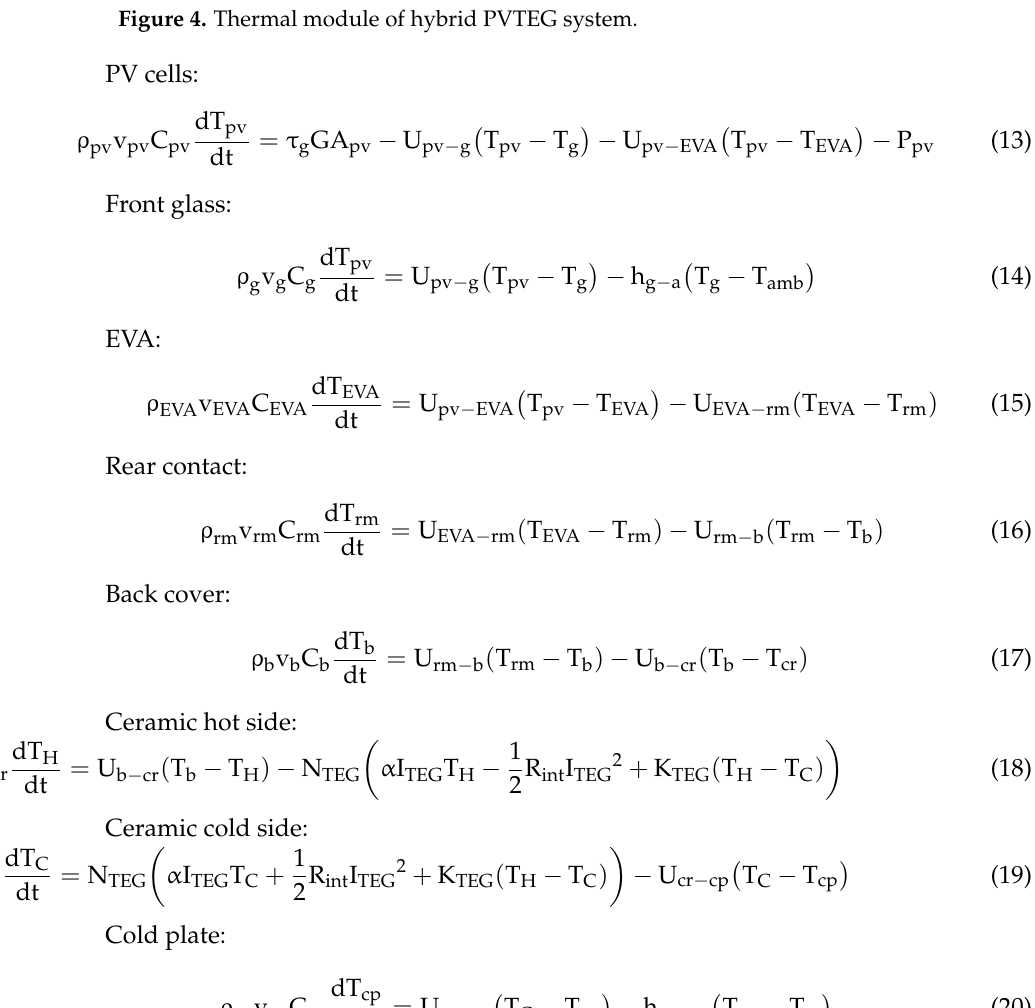
Table 3. Parameters from datasheets [24].